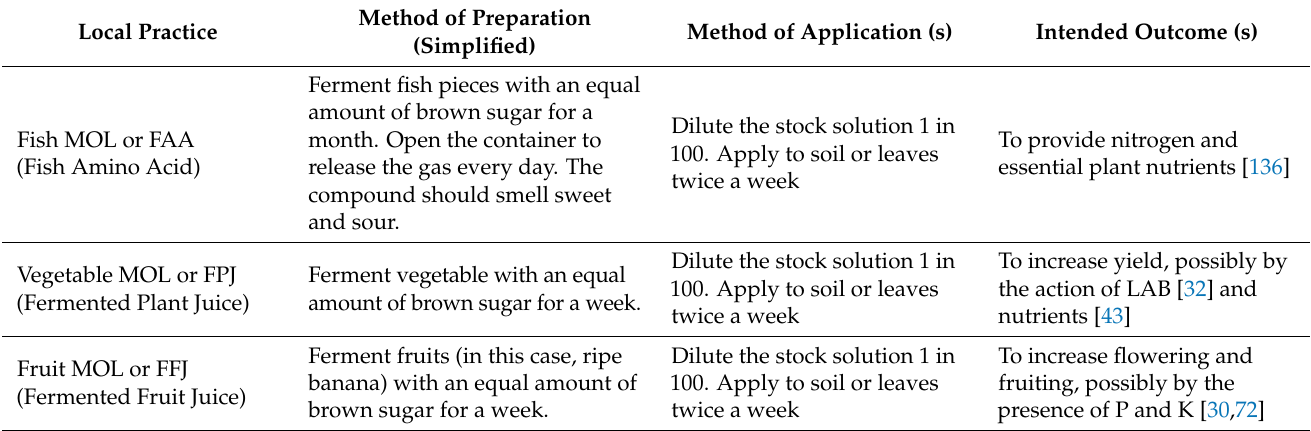
Table 4. The basic practice of food-based fertiliser involving fermentation by local households in Southeast